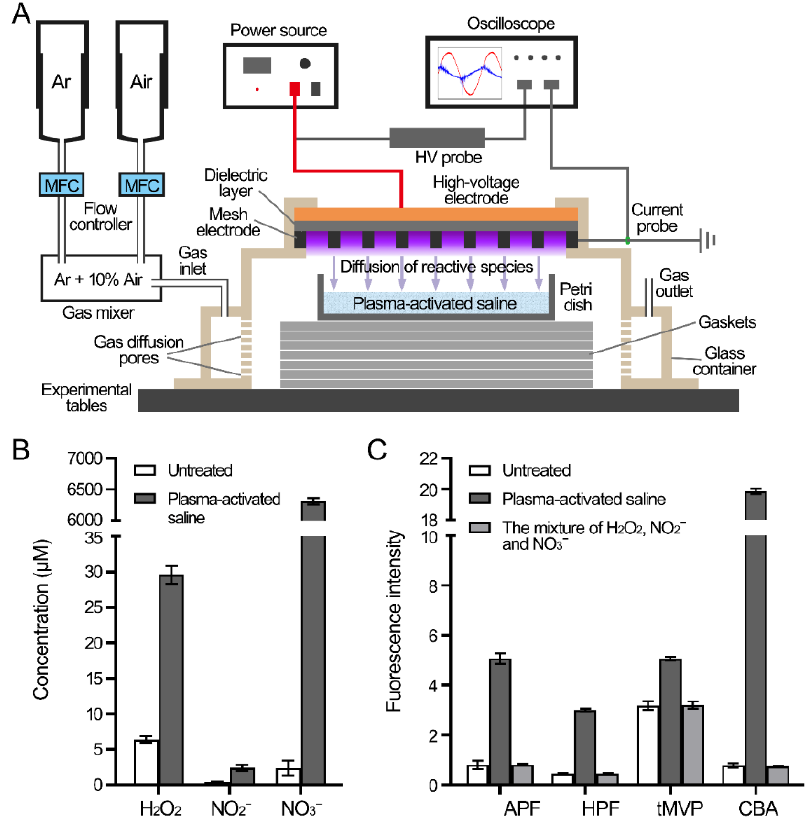
Figure 1. Reactive species in the PAS. ( A ) Diagram of the device for the preparation of PAS. ( B ) The concentrations of three long-lived species H 2 O 2 , NO 2 − , and NO 3 − in PAS. ( C ) The fluorescence intensities of the probes in PAS. Four probes APF, HPF, tMVP, and CBA were mixed with the PAS and untreated saline, then the fluorescence intensities were measured.